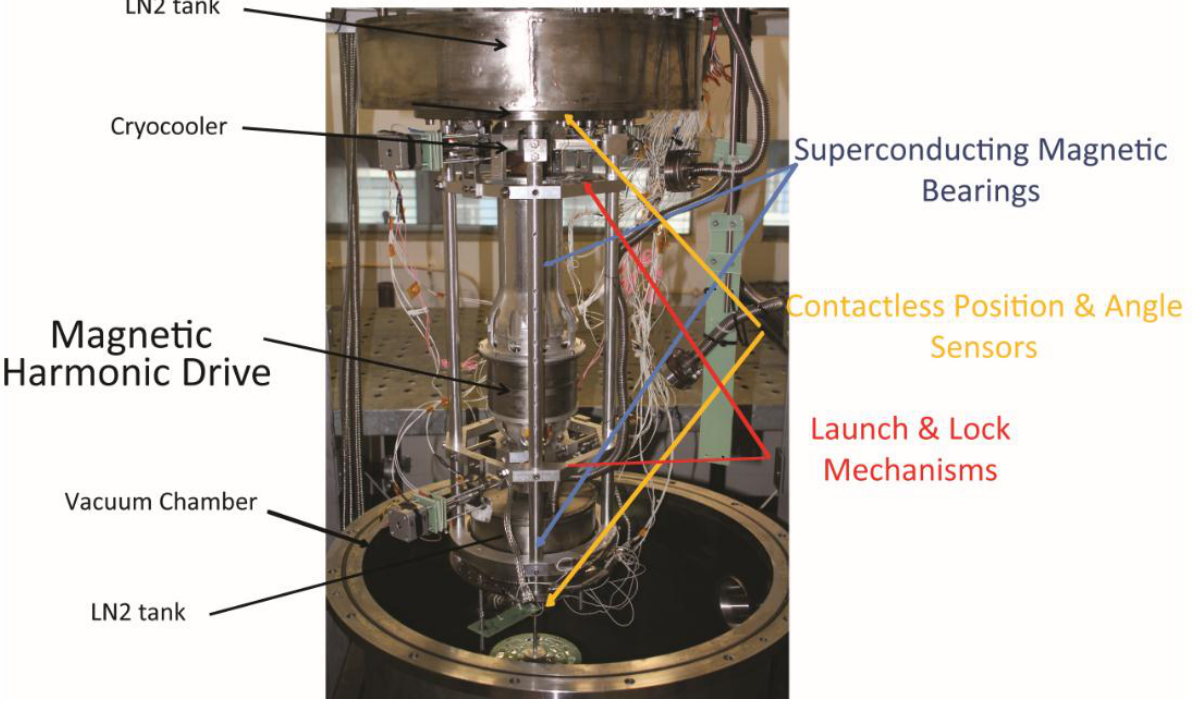
Figure 6. Prototype integrated in the thermal-vacuum